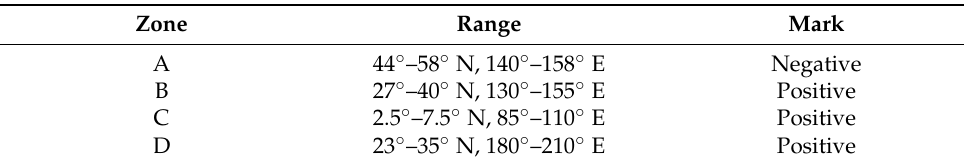
Figure 5. Differences in latent heat flux between peak and valley years of SRF in winter. Stippling indicates the grid points that passed the 0.05 significance test (unit: W/m 2 ). (Units: latitude is °N, and longitude is °E.). Table 2. The extent of anomalous latent heat flux regions.